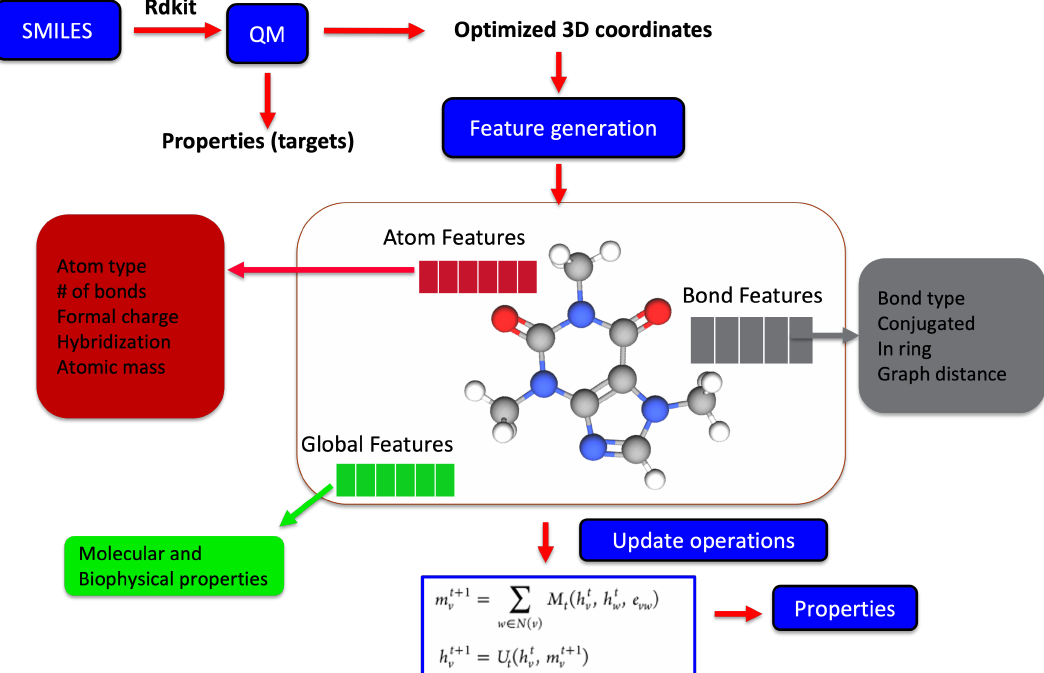
Figure 3. The iterative update process used for learning a robust molecular representation either based on 2D SMILES or 3D optimized geometrical coordinates from physics-based simulations. The molecular graph is usually represented by features at the atomic level, bond level, and global state, which represents the key properties. Each of these features are iteratively updated during the representation learning phase, which are subsequently used for the predictive part of